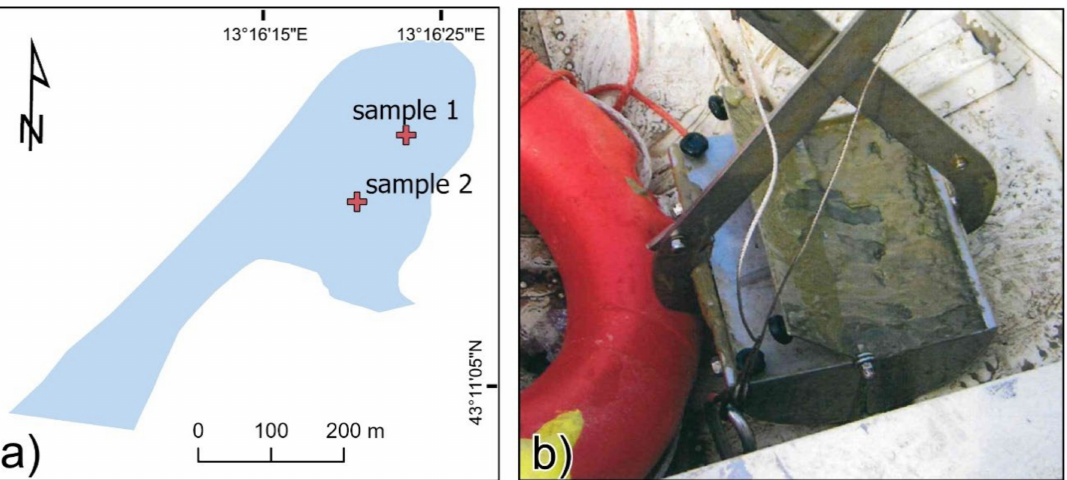
Figure 3. ( a ) Location of sampling sites; ( b ) “Van Veen” type bucket used for sediment